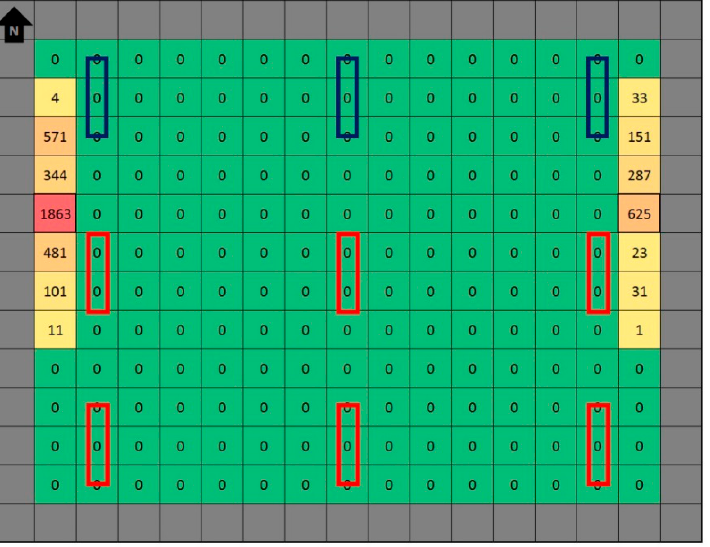
Figure 1. Plan view of a room showing a tally of the critical point locations across the year for a control zone that consists of two rows of luminaires with daylight entering through windows along the south wall. The top row of luminaires in this figure is not dimmed.